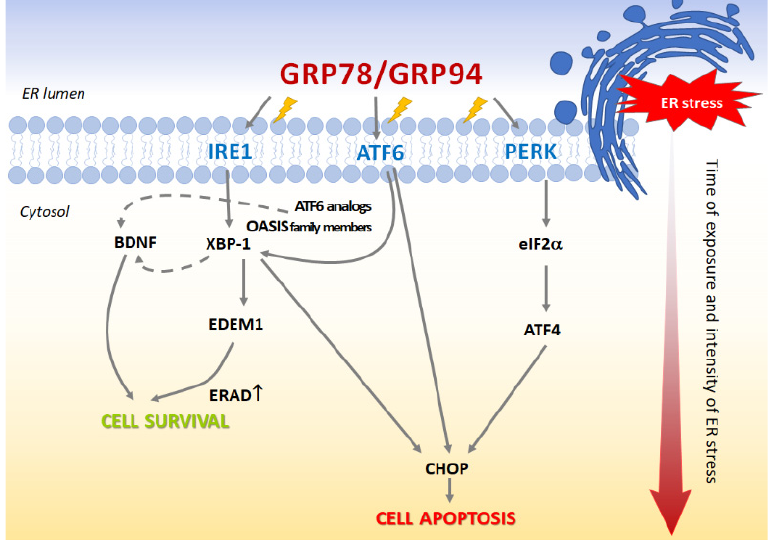
Figure 1. Under ER stress, the UPR pathway is activated to minimize the accumulation of unfolded and misfolded proteins in the ER. ATF4, activating transcription factor 4 ; ATF6, activating transcription factor 6 ; BDNF, brain-derived neurotrophin factor ; CHOP, C/EBP-homologous protein ; EDEM1, ER Degradation-Enhancing Alpha-Mannosidase-Like Protein 1 ; eIF2 α , eukaryotic translation initiation factor 2 α ; ER, endoplasmic reticulum ; ERAD, endoplasmic reticulum associated degradation ; GRP78, 78-kDa glucose-regulated protein ; GRP94, 94-kDa glucose-regulated protein ; IRE1, inositol requiring enzyme 1 ; XBP1, X-box binding protein 1 ; OASIS, old astrocyte specifically induced substance ; PERK, protein kinase R-like ER kinase ; dashed line—indirectly involved in the UPR pathway.